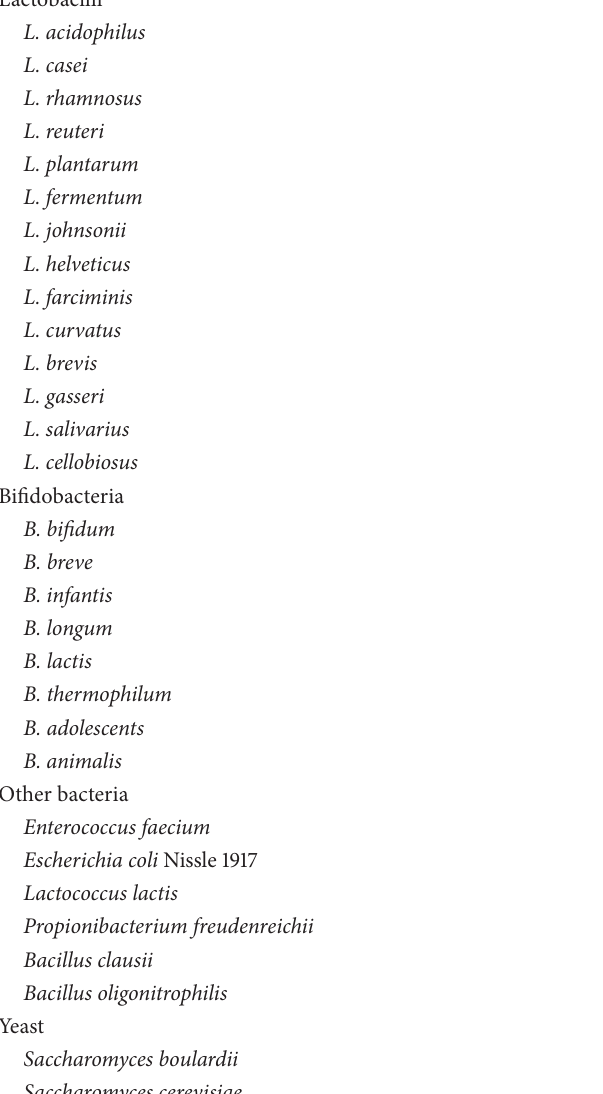
Table 1: Most common microorganisms studied for probiotic prop-